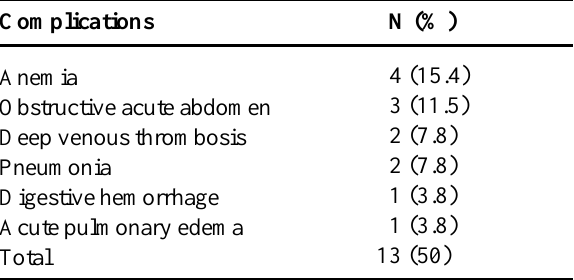
Table 5 – Postoperative complications related to progres- sion of neoplasia.